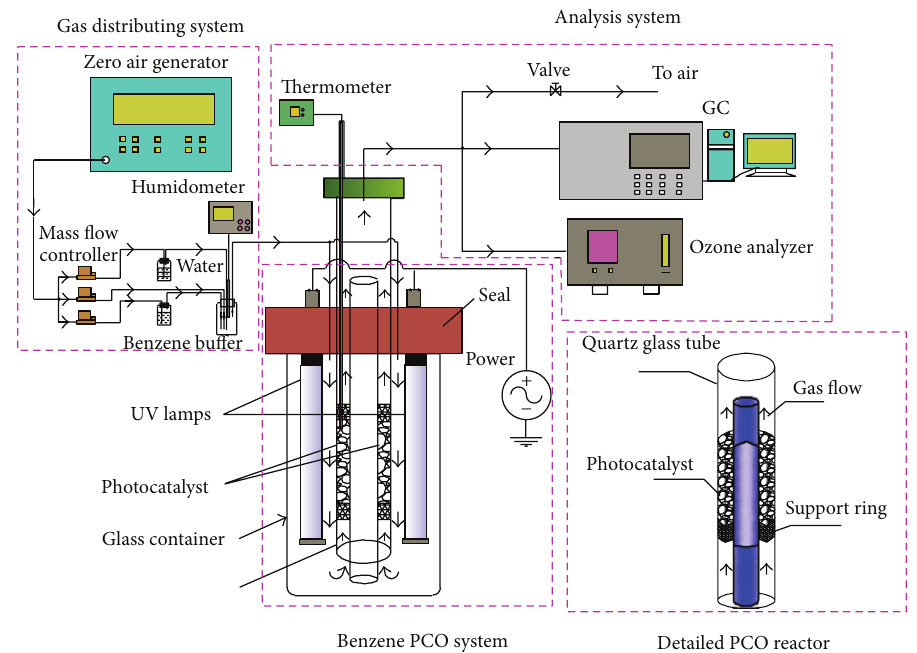
Figure 1: Schematic diagram of experimental